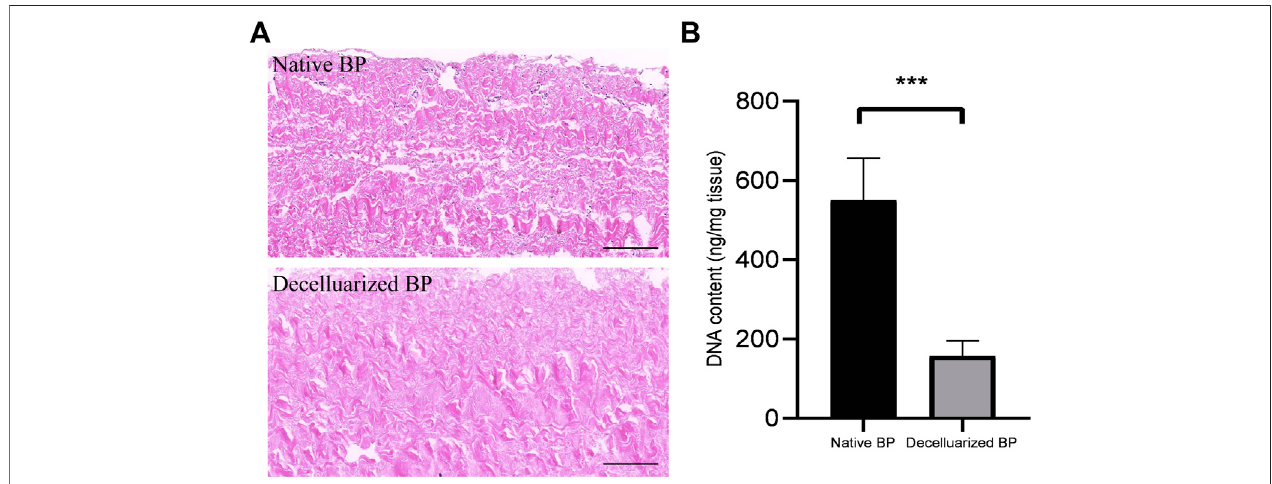
FIGURE 1 | Validation of the decellularisation process of the borcine pericardiums (BPs) (A) HE staining of native BP (Fig.1A,top) and decellularized BP (A) . The black bar indicates 100 um (B) Quantitative determination of DNA in native BP and decellularized BP ( n = 4; mean values ±s.d. p p < 0.05; pp p < 0.01; ppp p < 0.001; ns represents no signi fi cant